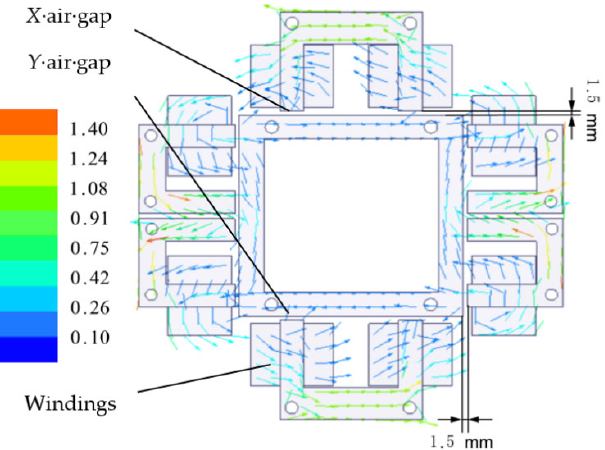
Figure 1. Structure of MDOFSC ( a ) Overall structure; ( b ) Suspension mechanism.